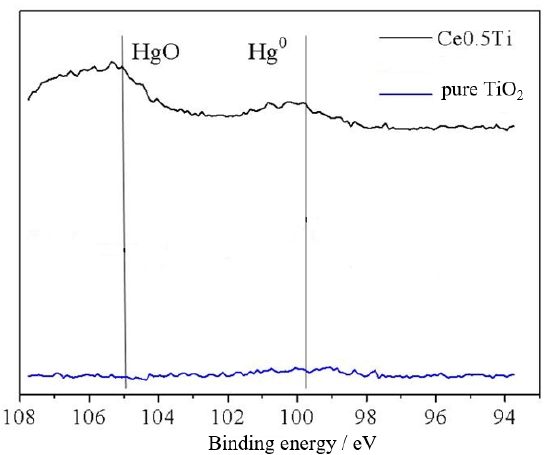
Figure 9. XPS results of Hg.